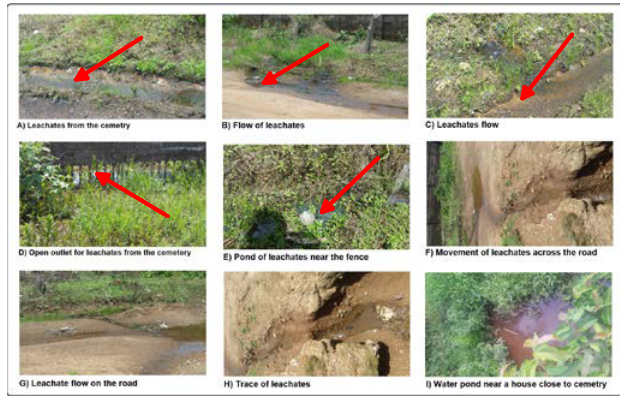
Conceptual Model Flow of Contaminants within a Typical Cemetery Close to a Flowing River.